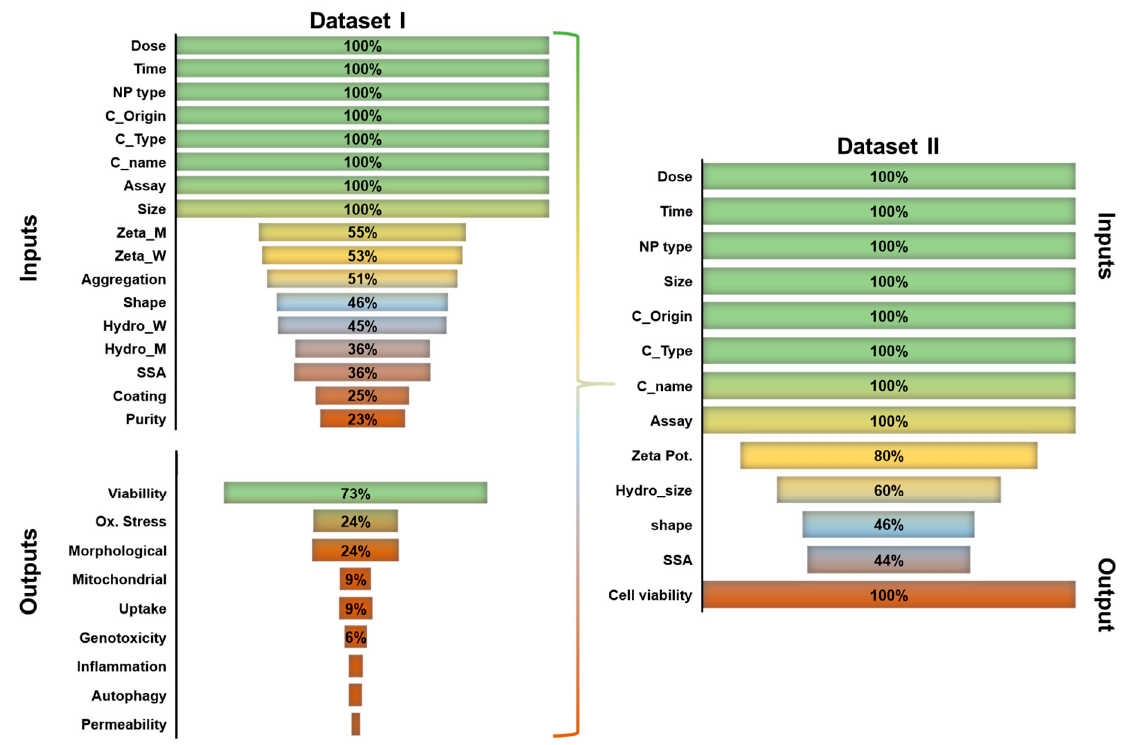
Figure 2. Dataset I completeness (percentages) of input parameters and the identified outcomes ( left ). Dataset II completeness of inputs with one outcome: cellular viability ( right ).